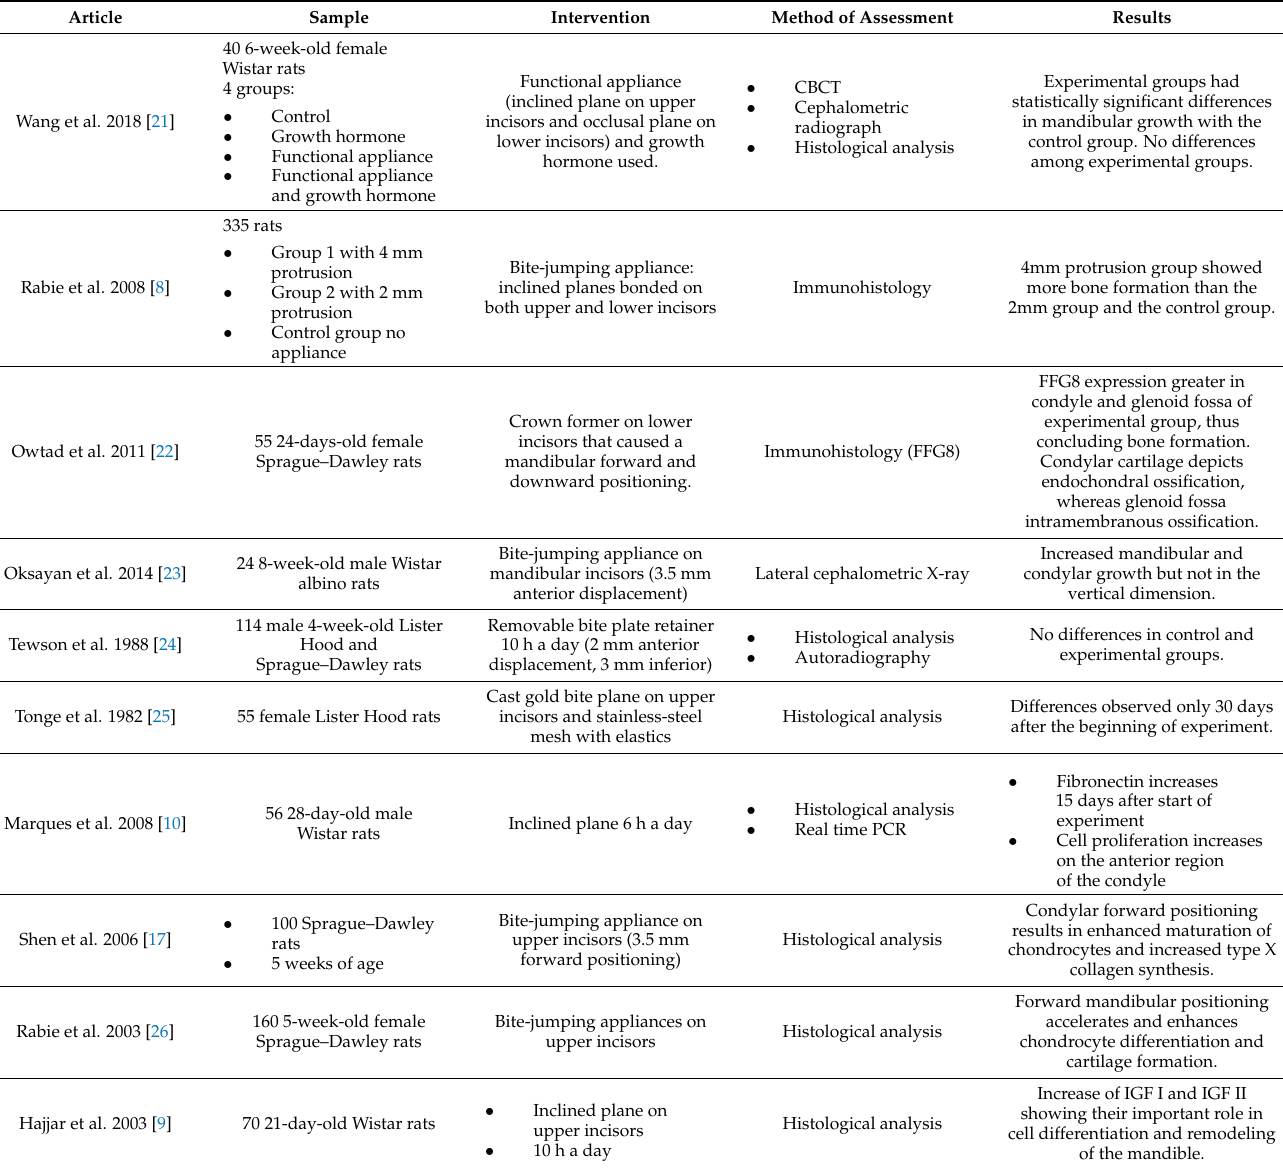
Table 2. Studies included in the